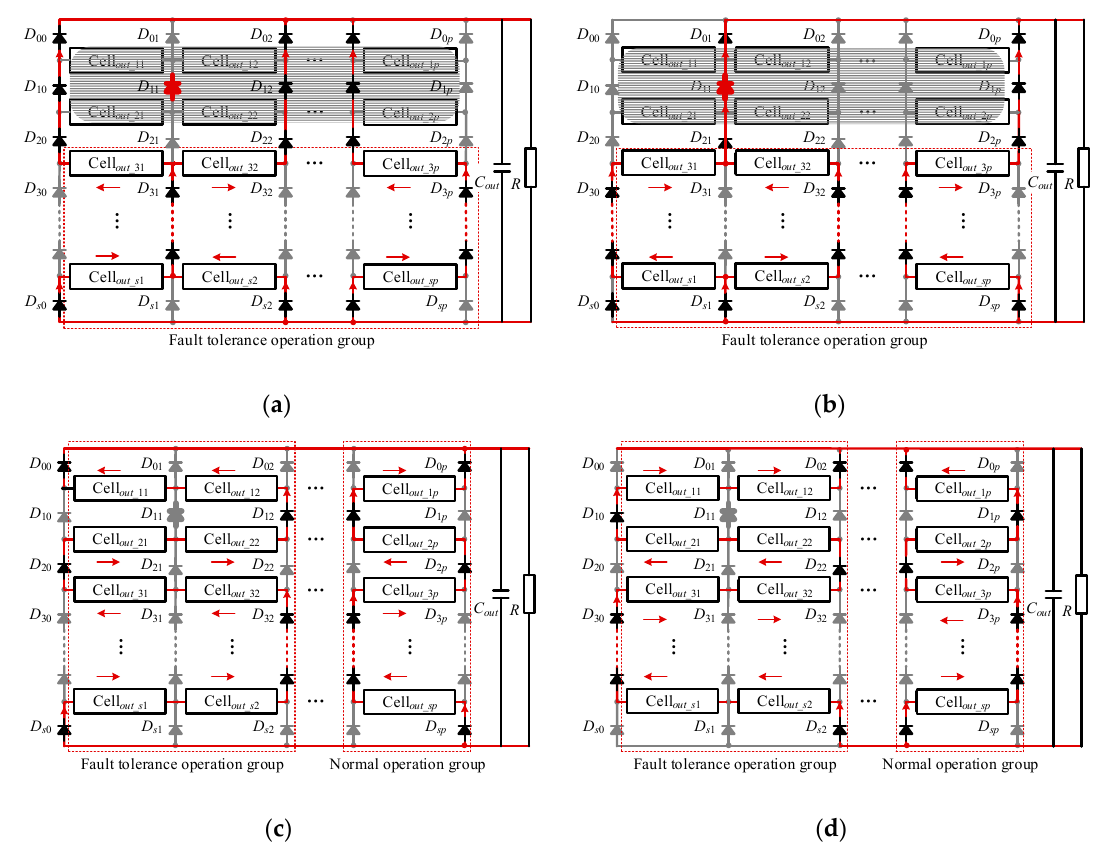
Figure 11. Fault tolerance without redundancy: ( a ) Working mode 1 under diode short-circuit; ( b ) Working mode 2 under diode short-circuit; ( c ) Working mode 1 under diode open-circuit; ( d ) Working mode 2 under diode open-circuit.